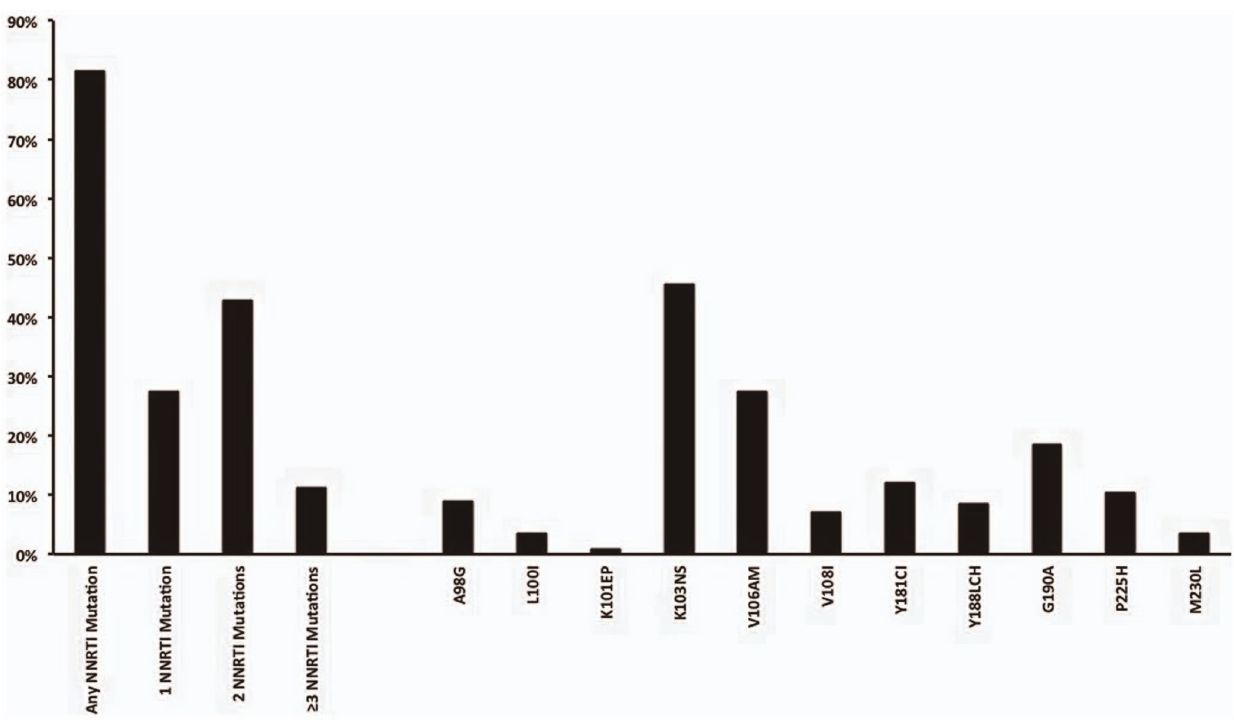
Figure 2. NNRTI mutations.